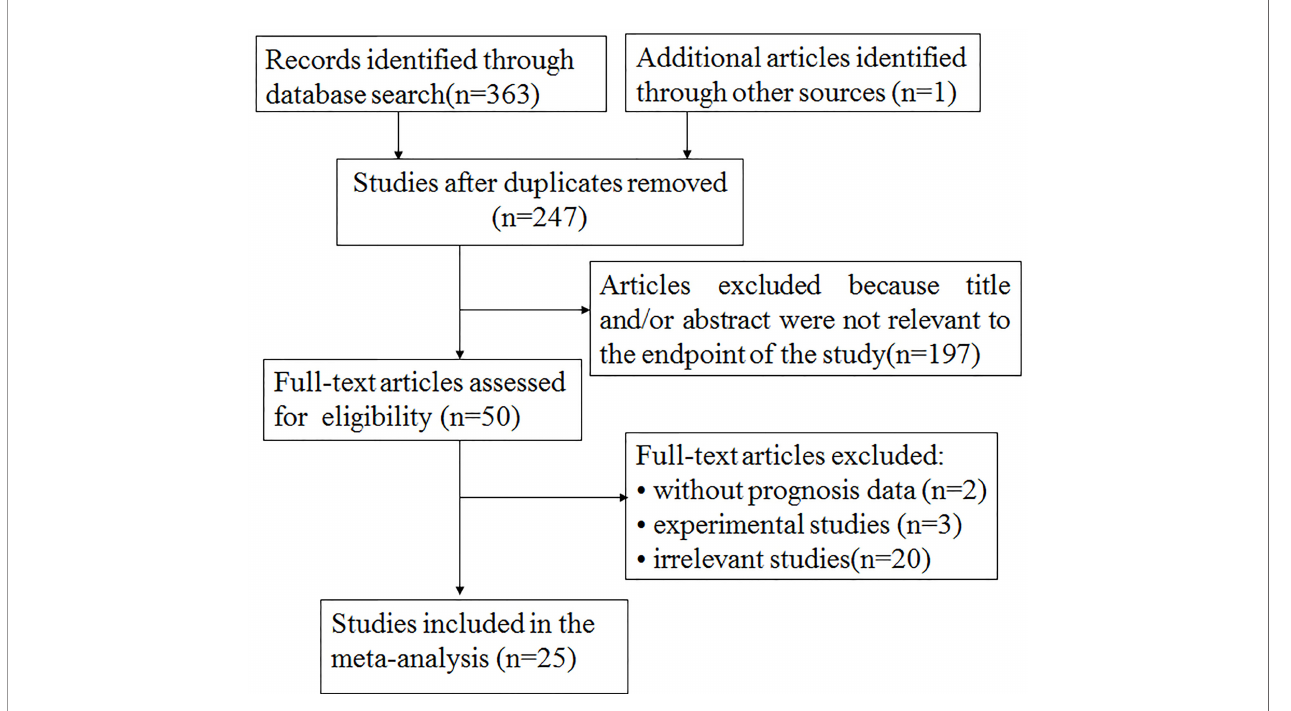
FIGURE 1 | The fl owchart of the selection process in our